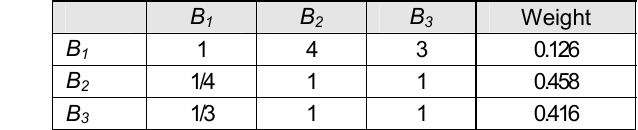
Table 10 – Matrix of the relevant importance of alternatives in relation to attribute A 5 (Effectiveness) Таблица 10 – Матрица релевантной значимости альтернатив по отношению к атрибуту A 5 ( Эффективность )